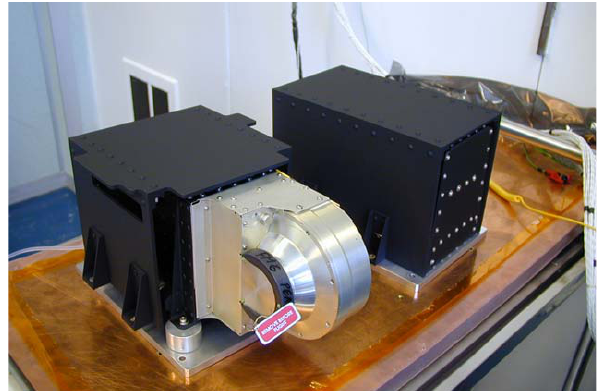
Figure 4. Cross section through a PEACE Sensor electrostatic analyser